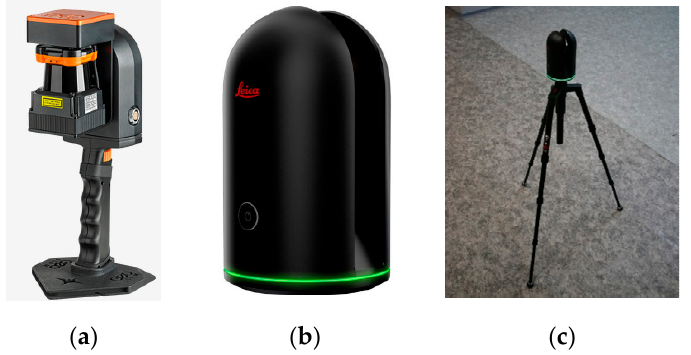
Figure 4. ( a ) Laser mobile scanner ZEB-REVO, ( b , c ) laser scanner BLK360.